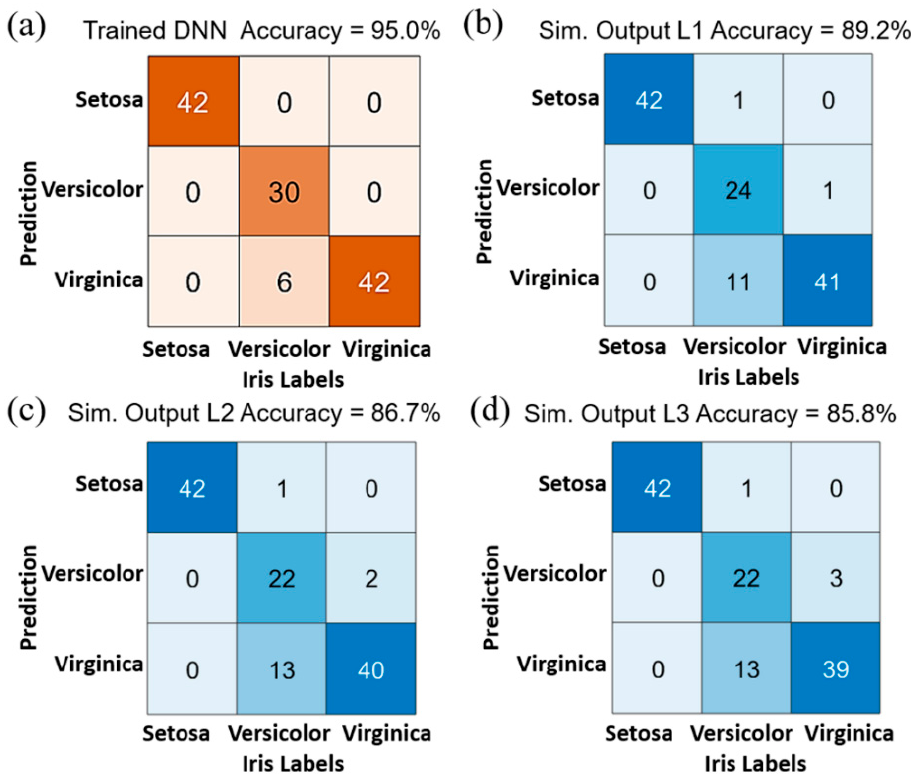
Figure 6. ( a ) Label prediction of the trained DNN, indicating an accuracy of 95%. ( b ) Simulated image prediction using photonic DNN as the 1st hidden layer, with an accuracy of 89.2%. ( c ) Simulated label prediction using photonic DNN as the 1st and 2nd hidden layers, with an accuracy of 86.7%. ( d ) Simulated label prediction of the 3-layer photonic DNN, with an accuracy of 85.8%.